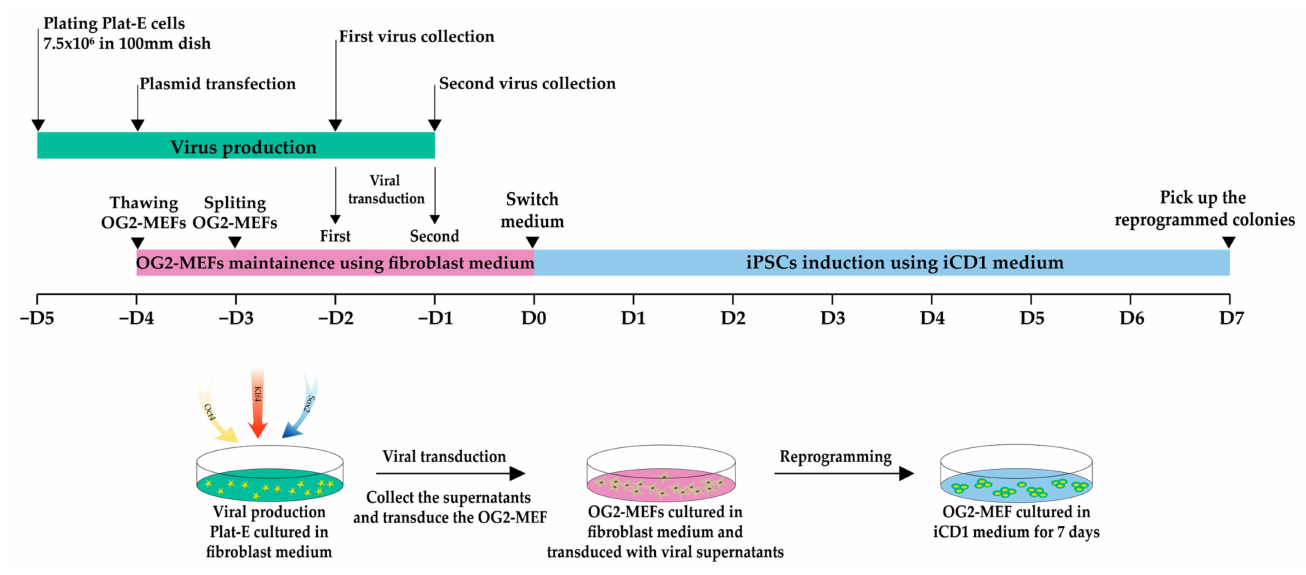
Figure 1. Workflow of iPSC generation from OG2-MEFs using iCD1. Timeline of viral production, OG2-MEFs preparation and transduction, and iPSC induction. Arrows indicate the key steps at different time points. OG2-MEFs (1 × 10 4 cells) are split and plated in a 12-well